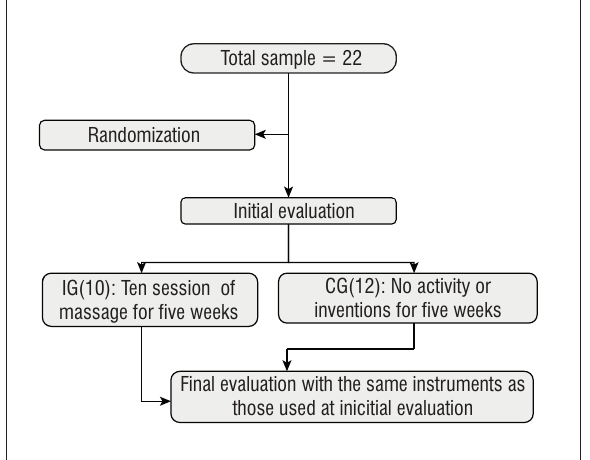
Figure 1 - Description of the allocation process and evalua- tion of the volunteers in the study